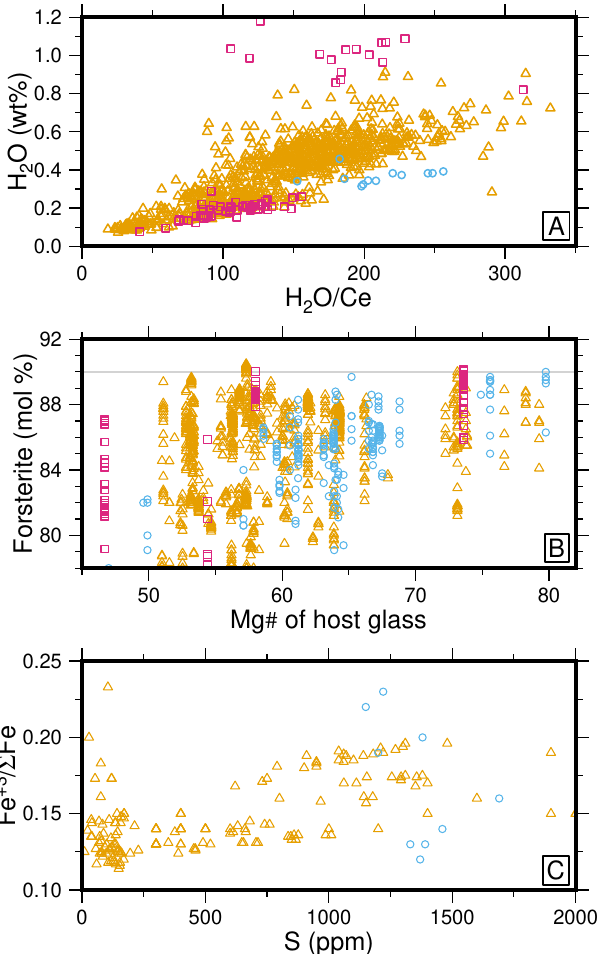
Figure 4: Hawaiian islands geochemical data (see Table 2 for details). [A] H O content of melt as a function of H O/Ce. Col- 2 2 ored triangles/squares/circles denote geochemical data from shield/post-shield/rejuvenated volcanic phases. [B] Rhodes di- agram showing Fo# of olivines as a function of whole-rock Mg#. Gray line shows Fo# = 90 for reference. [C] Fe +3 / Σ Fe of melt as a function of S